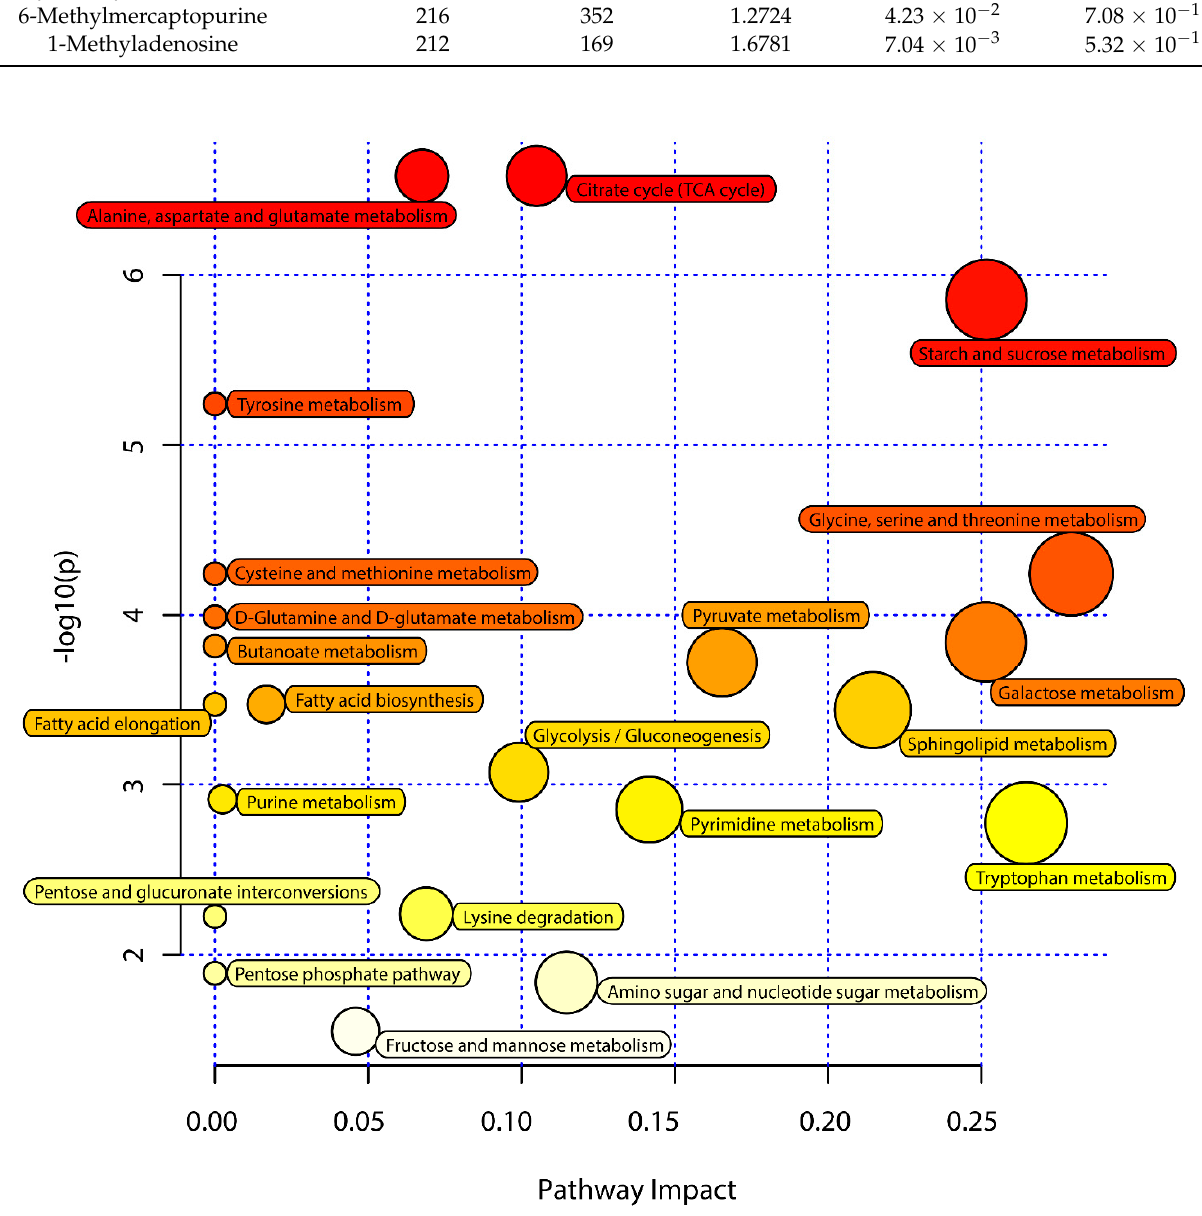
Figure 4. Pathway analysis of the M. micrantha leaves (ML) diet and pinewood (PW) diet groups. The y -axis represents negative log( p ) values from pathway enrichment analysis, the x -axis represents impact values from the pathway topology analysis. The color and size of the shapes represent the effects of the ML diet on termite metabolism relative to the PW diet; large, red shapes indicate a greater effect on the pathway.